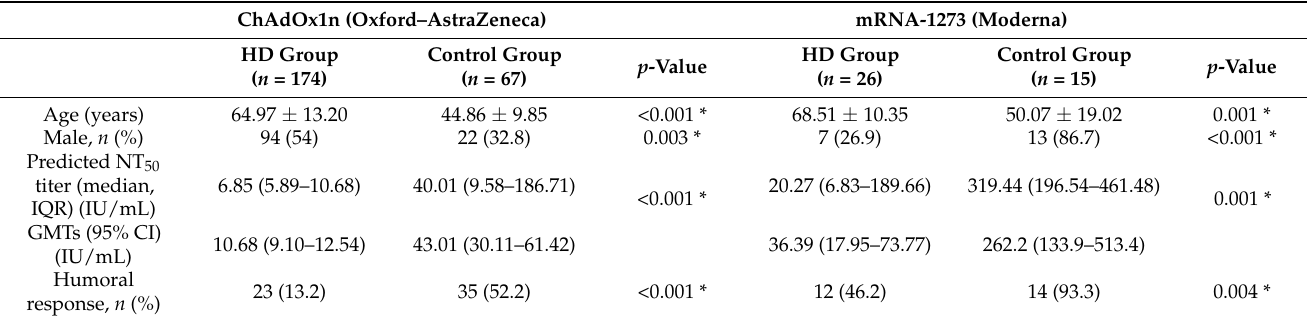
Table 4. Different humoral responses to two types of COVID-19